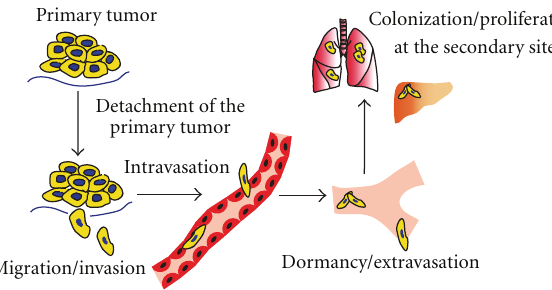
Figure 1: The steps of the metastatic